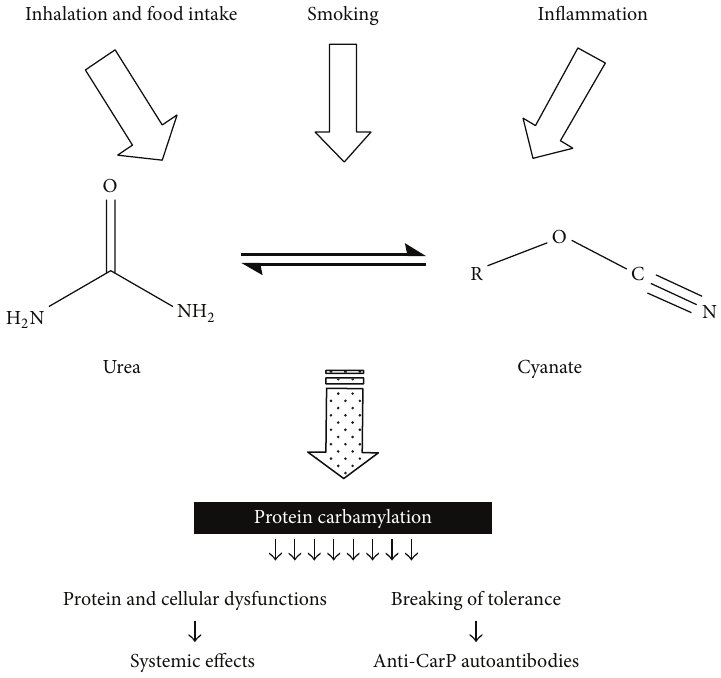
Figure3:Proteincarbamylation:causesandconsequences.Severalconditionscanshiftthebalancebetweenureaandcyanatetowardscyanate production, enhancing in this way the process of protein carbamylation. This event results in systemic effects and production of anti-CarP